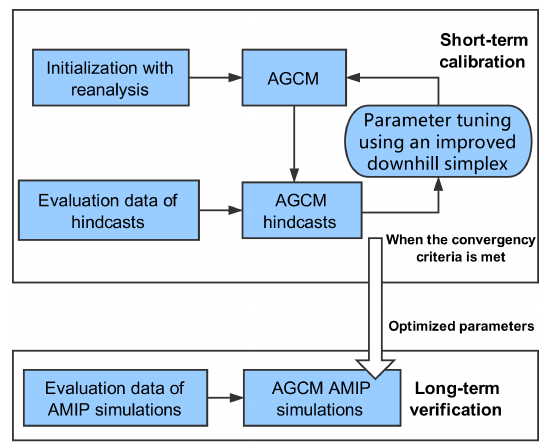
Figure 2. Flow diagram of the automatic calibration of parameters via the short-term CAPT and the verification of optimized parame- ters through long-term AMIP simulations.